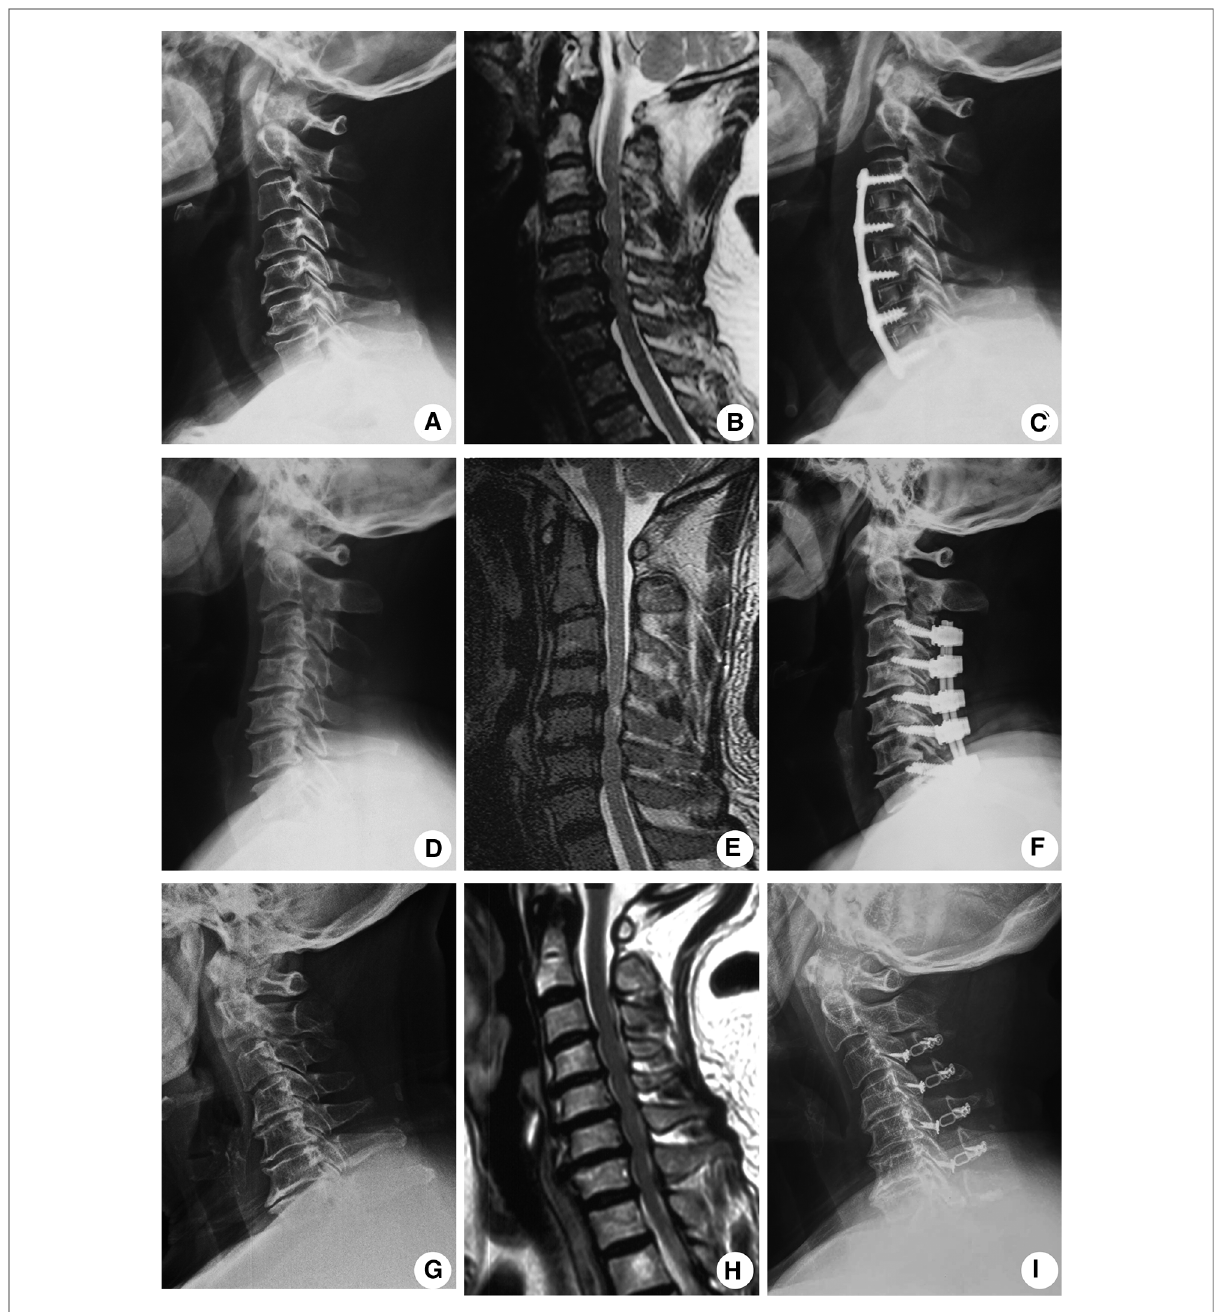
FIGURE 1 Typical radiological images showing four-level CSM patients treated with either ACDF, LAMP, or the LF approach. Representative preoperative lateral position x-ray radiograph ( A ), preoperative MRI image ( B ), and x-ray radiographs at a 2-year follow-up ( C ) of ACDF-treated patients. Representative preoperative lateral position x-ray radiograph ( D ), preoperative MRI image ( E ), and x-ray radiographs at a 2-year follow-up ( F ) of LF-treated patients. Representative preoperative lateral position x-ray radiograph ( G ), preoperative MRI image ( H ), and x-ray radiographs at a 2-year follow-up ( I ) of LAMP-treated